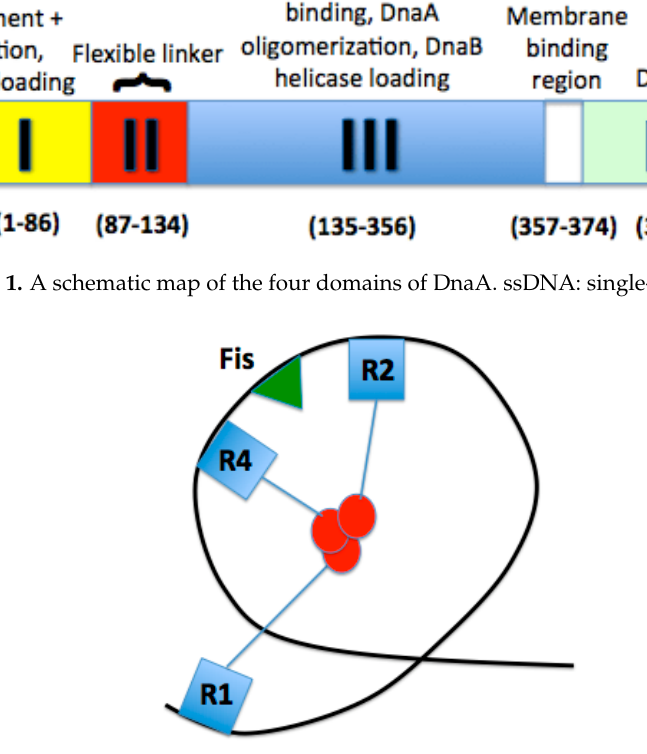
Figure 2. Proposed loop conformation of inactive oriC, constrained by DnaA bound to high ‐ affinity sites R1, R2, and R4 via domain I N ‐ terminus interactions. This conformation is facilitated by Fis.